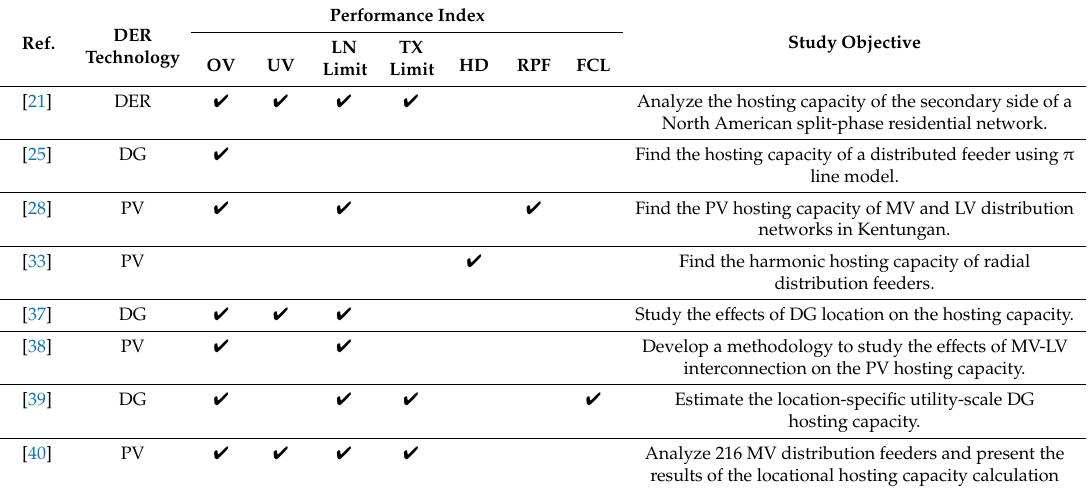
Table 1. Studies that utilize the constant source method for hosting capacity evaluation. Ref.